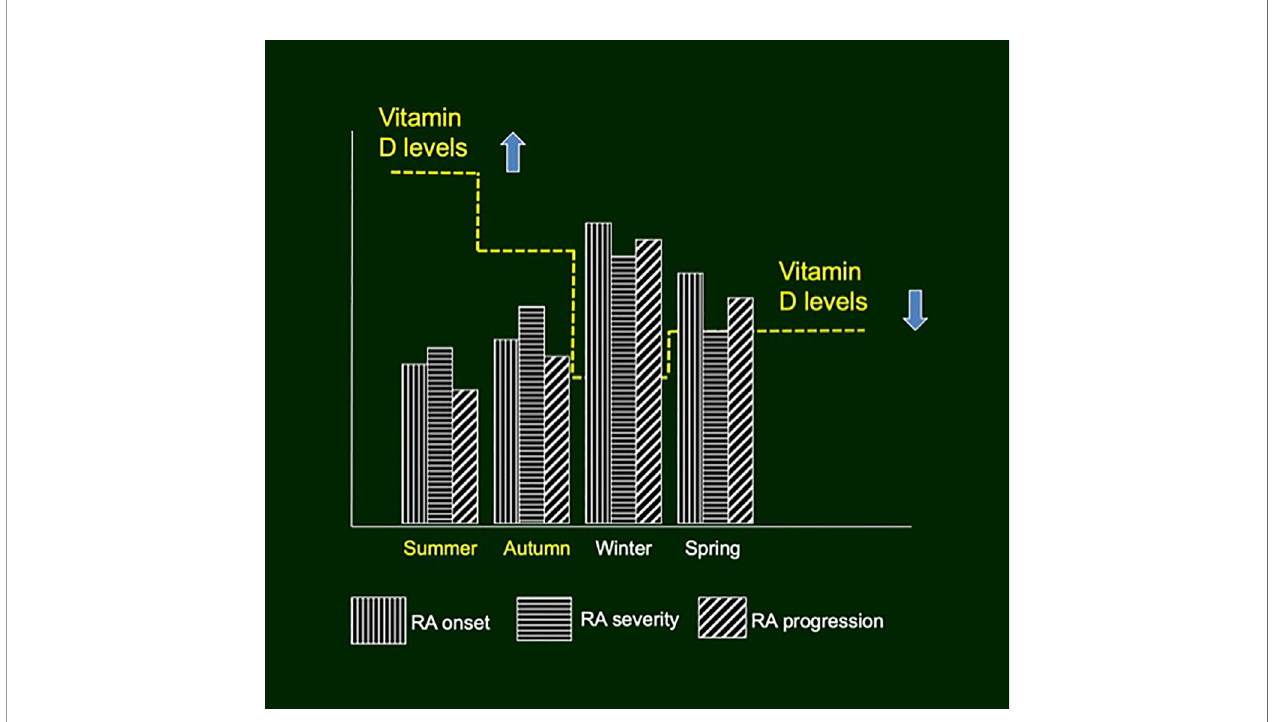
FIGURE 1 | Seasonal variations of rheumatoid arthritis incidence, severity and progression, according to vitamin D serum